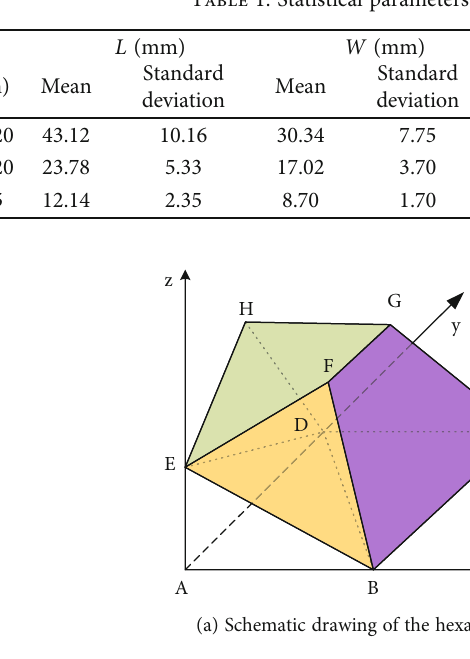
Figure 7: 3D clump particle model. Table 2: Mesoparameters of particle for gravel-sand mixtures.